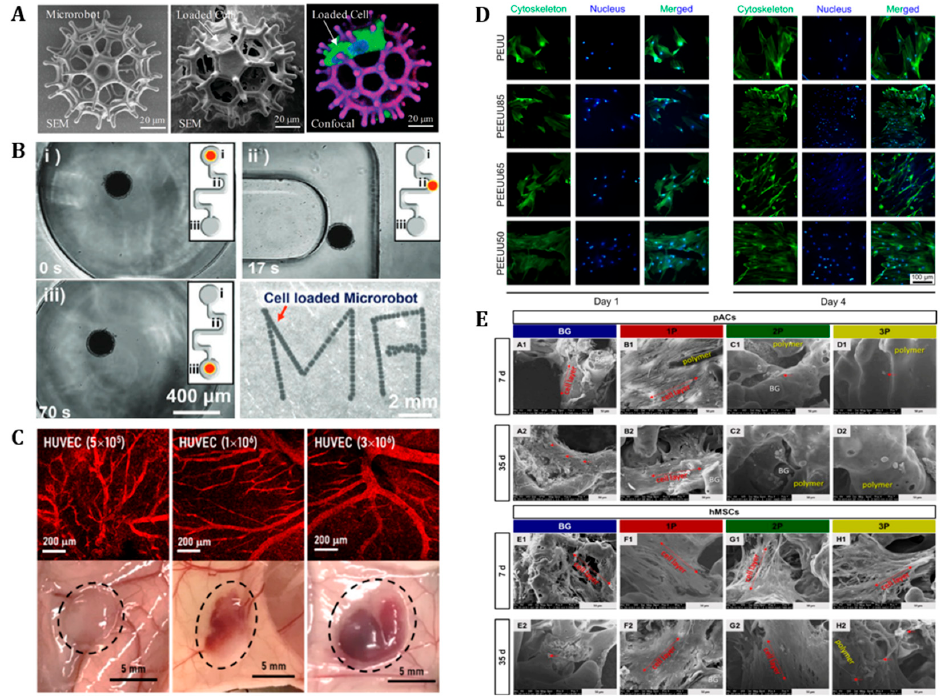
Figure 6. Biodegradable tissue engineering. ( A ) SEM images of a PEGDA-PETA microrobot structure (left), cell-loaded microrobot (middle), and confocal scan of green fluorescent protein (GFP)-labeled MSCs (GFP-MSCs) cultured on the microrobot (right). Reproduced with permission [152]. Copyright 2020, Wiley-VCH. ( B ) Magnetic actuation of the microrobot in a confined microfluidic channel ( i – iii ), and the magnetic manipulation of the GelMA microrobot to write “MR”. Reproduced with permission [77]. Copyright 2022, Wiley-VCH. ( C ) Representative CLSM images of DFO (0.1%) and HUVEC (5 × 10 5 ,1 × 10 6 , and 3 × 10 6 )-laden P5L1.1 gels (nanocomposite gels containing 5.0% ( w / v ) PLGA-PEG-PLGA and 1.1% ( w / v ) laponite), formed in the subcutaneous tissue of mice. Reproduced with permission [80]. Copyright 2022, The American Chemical Society. ( D ) Immunofluorescence images of vSMCs cultured on PEUU, PEEUU85, PEEUU65, and PEEUU5 with the labeling of the cytoskeleton (green) and nucleus (blue) after 1 and 4 days, respectively. Reproduced with permission [153]. Copyright 2022, The American Chemical Society. ( E ) SEM images of colonized, bioactive glass-based scaffolds. BG, 1P, 2P, and 3P mean the pure bioactive glass, single, twofold, and threefold PLGA infiltrations. Reproduced with permission [160]. Copyright 2022, MDPI.